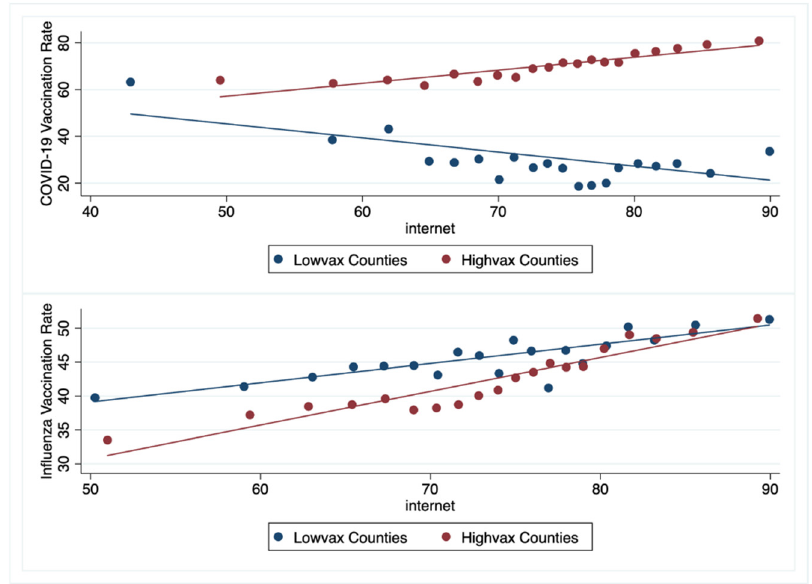
Figure 5. The association between Internet access and vaccination rates for low- and high- vax counties.